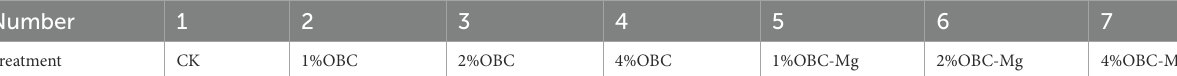
TABLE 3 Experiment design.